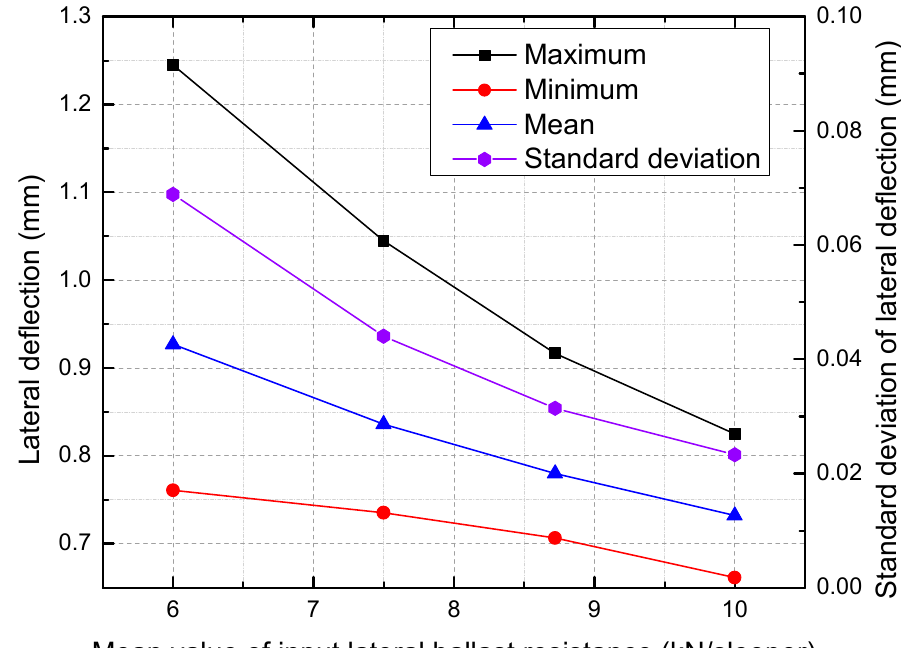
Figure 17. The maximum, minimum, mean, and standard deviation of lateral deflection under different mean values.